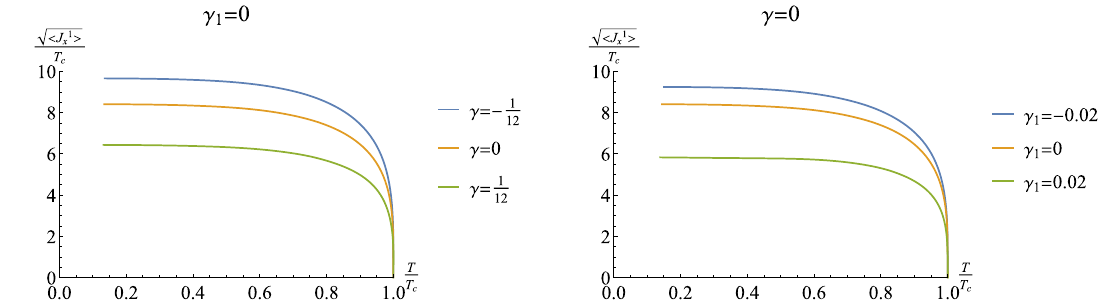
Fig. 1 The condensation < J 1 x > as a function of temperature. Left plot is for the 4 derivative theory and the right plot is for the 6 derivative